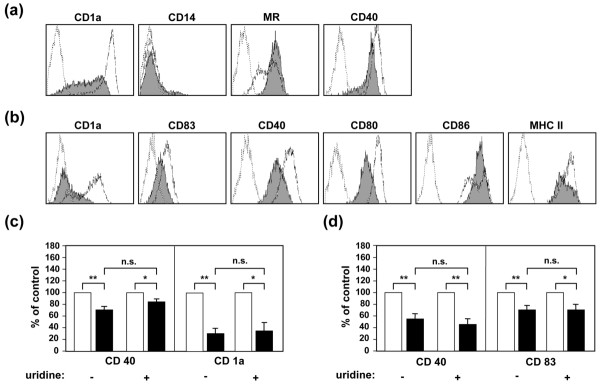
LEF-M interferes with DC differentiation. (a) Monocytes were cultured for 5 days with granulocyte–macrophage colony-stimulating factor (GM-CSF; 50 ng/ml) plus IL-4 (10 ng/ml) in the absence or presence of 150 μmol/l of the active metabolite of leflunomide (LEF-M). Subsequently, surface marker expression was determined using fluorescence-activated cell sorting (FACS) analysis. Open profiles with dotted line represent staining pattern with an isotype control antibody, open profiles with fine line indicate the staining pattern of differentiated control dendritic cells (DCs) stained with the indicated mAbs, whereas solid grey profiles show staining of DCs differentiated in the presence of LEF-M. (b) Myeloid precursor cells differentiated in the presence of LEF-M are resistant to maturation. Cells were treated as described above and then stimulated with lipopolysaccharide (LPS; 100 ng/ml) for 48 hours. Open profiles with dotted line represent staining pattern with an isotype control antibody, open profiles with fine line indicate staining of activated control DCs, and solid grey profiles show staining of DCs differentiated in the presence of LEF-M and subsequently exposed to LPS. Data are representative of at least four independent experiments. (c,d) The effects of LEF-M on DC differentiation are independent of pyrimidine depletion. The respective change in mean flourescence intensity (MFI) are shown (c) after the differentiation phase for CD40 and CD1a and (d) after subsequent maturation with 100 ng/ml LPS for CD40 and CD83 with and without 50 μmol/l uridine. White bars represent control DCs, and black bars indicate LEF-M-treated cells. Shown are mean percentage control responses ± standard error of the mean, calculated from five to eight independent experiments. Student's t-tests were calculated for control versus LEF-M-treated DCs and for LEF-M-treated DCs versus without uridine addition, as indicated. *P < 0.05, **P < 0.01.